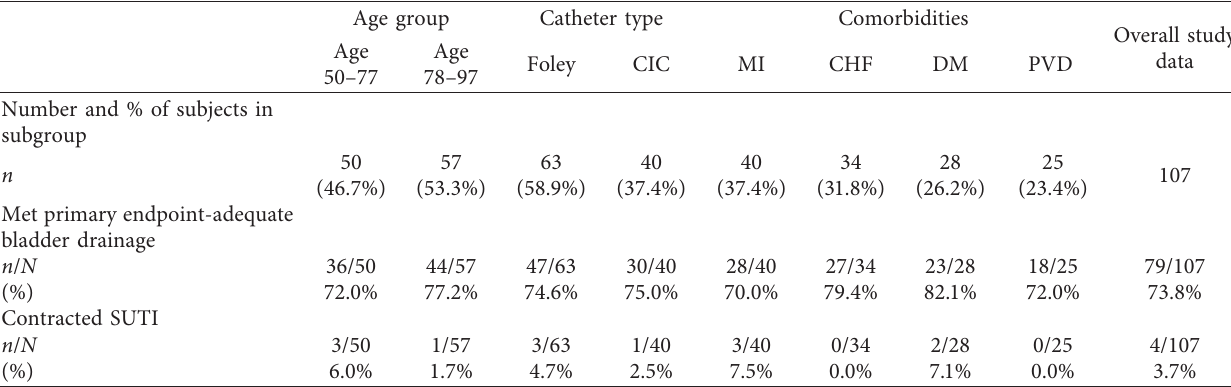
Table 3: Subgroup analyses.